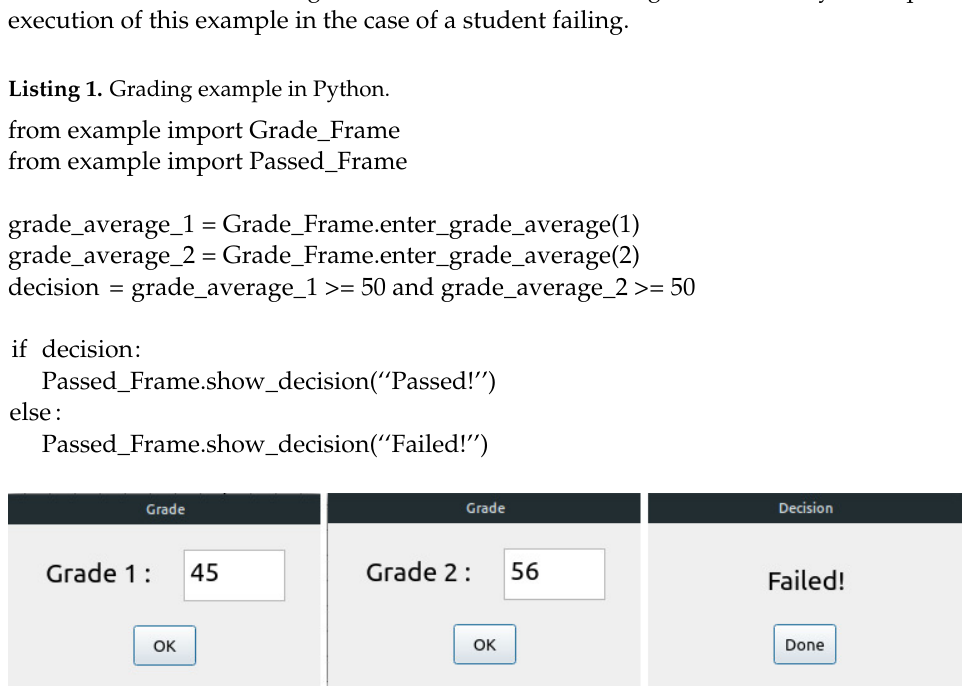
Figure 1. The sequential execution of the grading